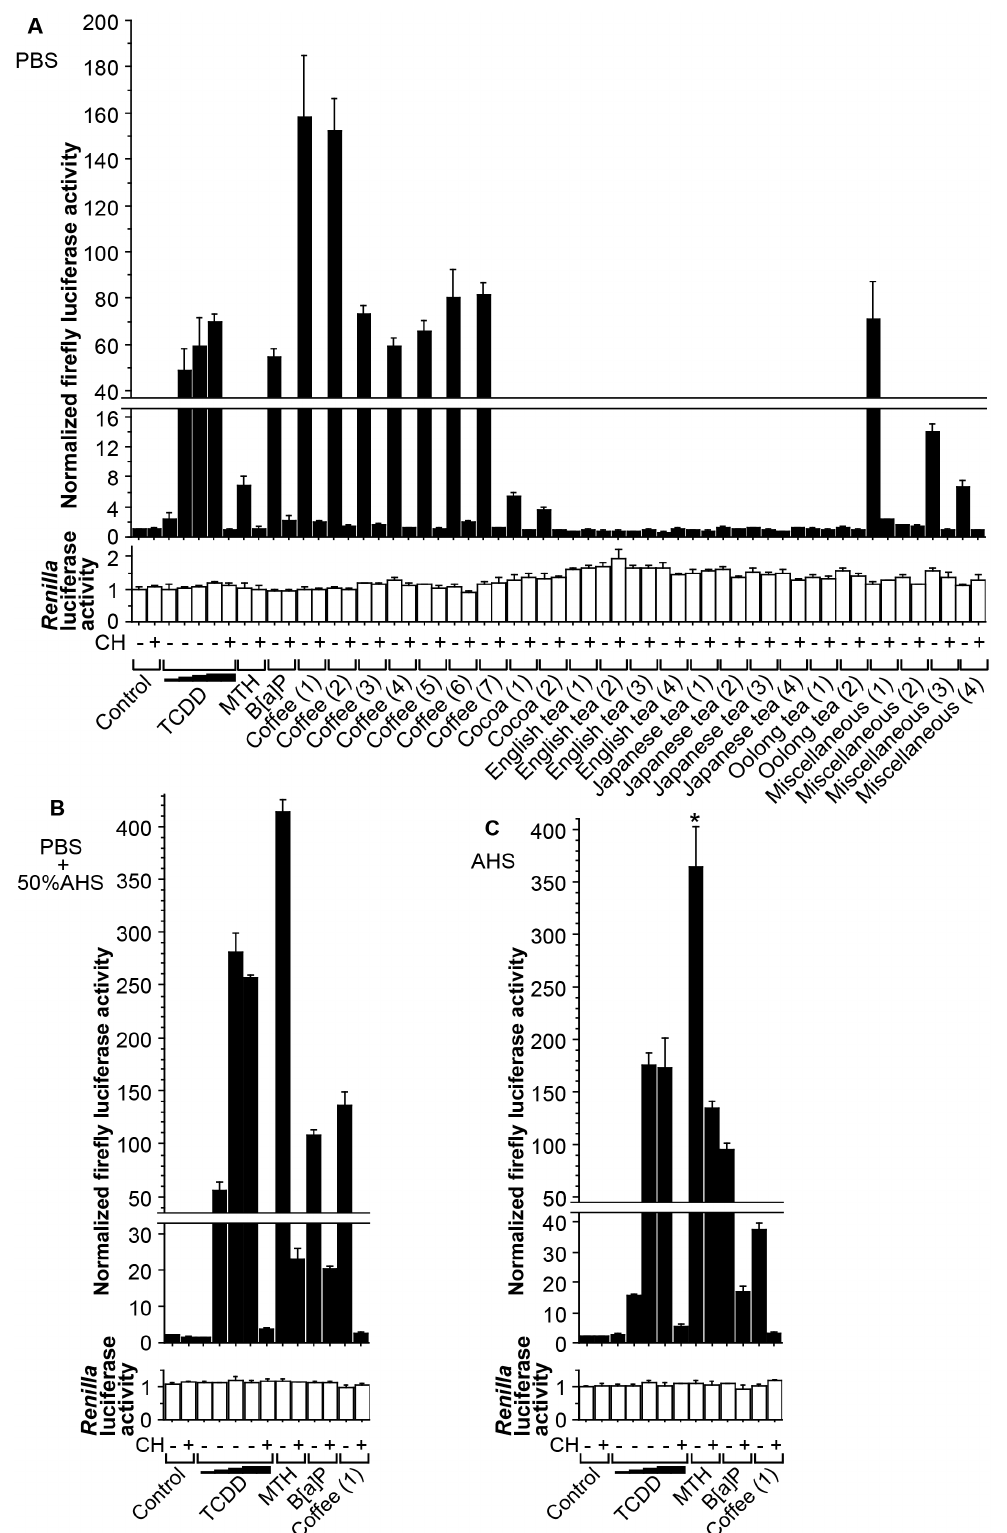
Figure 3. AhR activation by coffee and other beverages. HepG2-XRE cells were placed for 4 h in PBS ( A ), PBS with 50% (v/v) AHS ( B ), or AHS ( C ), with chemicals or beverages (Table 1). Renilla luciferase activity is shown for the same purpose as in Fig. 1. ‘‘CH + ’’ and ‘‘CH 2 ’’ indicate co- treatment with 10 m M CH and its vehicle 0.1% (v/v) DMSO, respectively. Because 0.1% (v/v) DMSO was used as a vehicle for TCDD (10 2 9 , 10 2 8 , 10 2 7 and 10 2 6 M), MTH (80 m M) and B[a]P (10 m M), an equal amount of DMSO was added as a control, in the samples where TCDD, MTH, or B[a]P was not added (i.e., all the columns other than the 3 rd through 11 th columns). In the samples where beverages [10% (v/v)] were not tested (i.e., the 1 st through